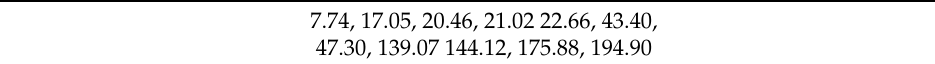
Table 5. Time to electric breakdown